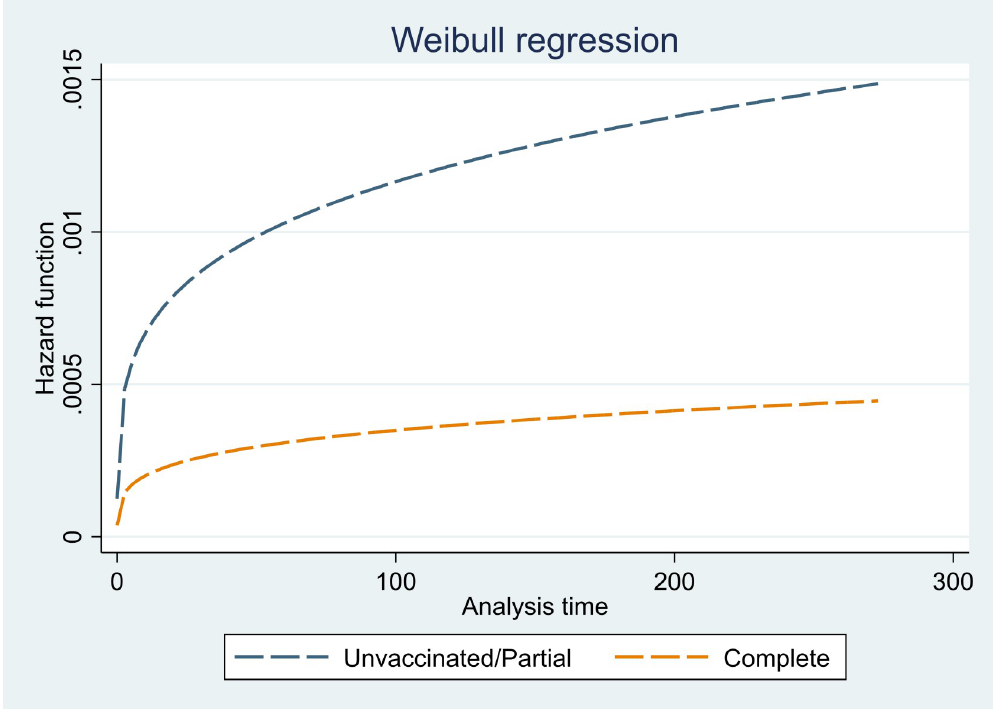
Fig 2. Hazard function for unvaccinated/partially vaccinated group and completely vaccinated group in 2762 health care staff in Mumbai, India.